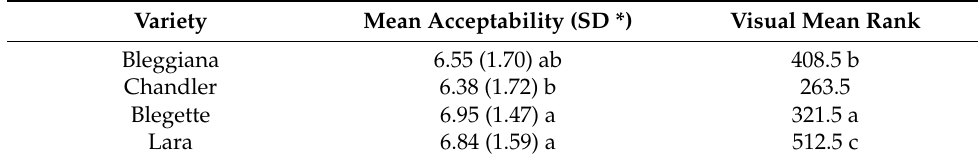
Table 2. Acceptability mean values on tasting and the mean rank for visual preference for each variety with indication of homogeneous groups (different letters correspond to significantly different means with p <